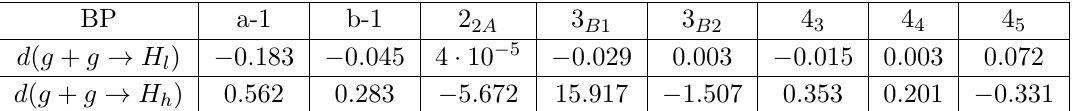
Table 8 . The coe(cid:14)cient in front of the scale dependent logarithm of the percentage correction is shown for the benchmark points that are not in the alignment limit ( c (cid:11)(cid:12)